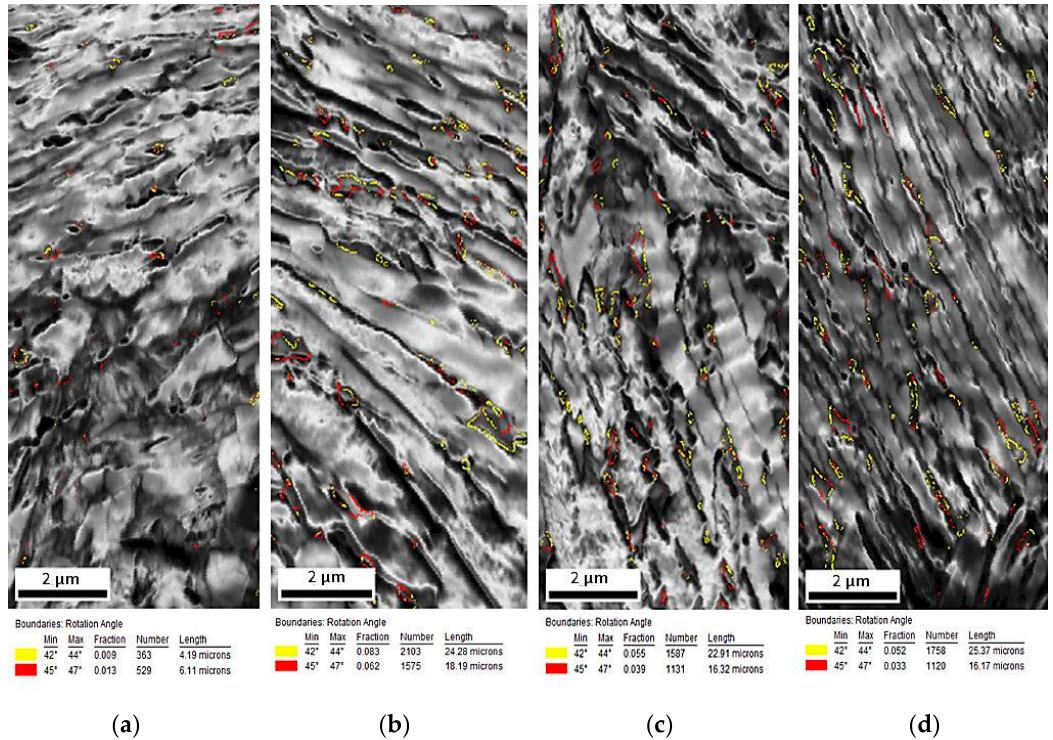
Figure 10. Maps displaying the boundary character between γ and α grains in the investigated steel deformed at: 20 °C ( a ), 60 °C ( b ), 100 °C ( c ), and 200 °C ( d ).